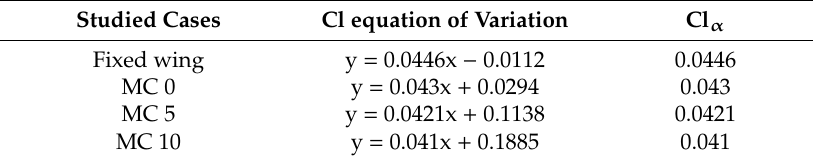
Table 7. Values of 𝑐𝑙 ∝ for each case study.